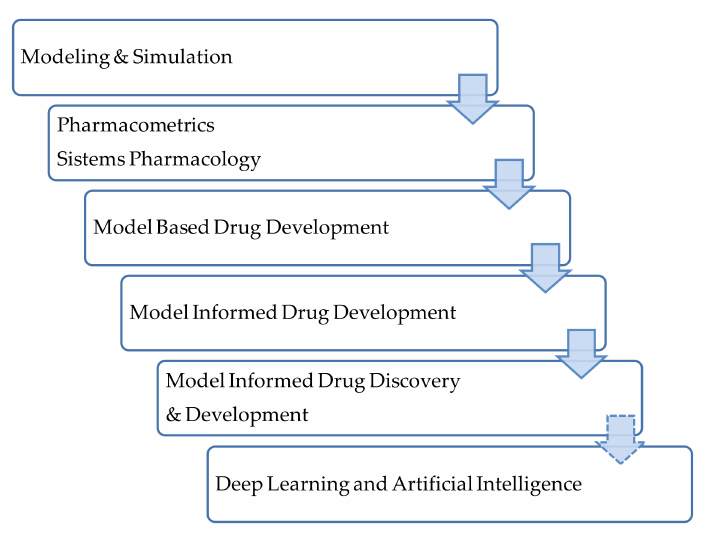
Figure 6. Terminology used for quantitative approaches for data analysis. Adapted from [55]; Published by the American Society for Clinical Pharmacology and Therapeutics,